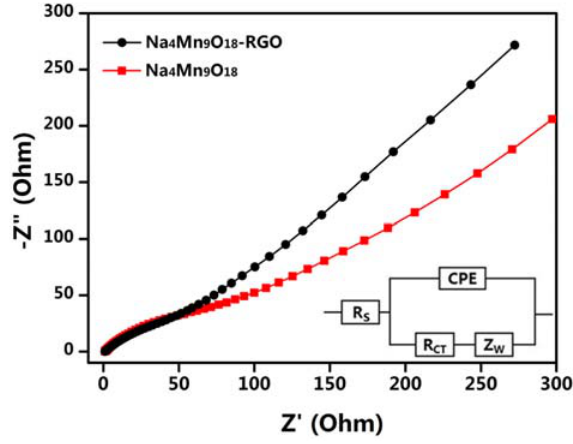
Figure 8. EIS of the Na 4 Mn 9 O 18 -RGO and Na 4 Mn 9 O 18 electrodes and the equivalent circuit model of plot fitting (inset).